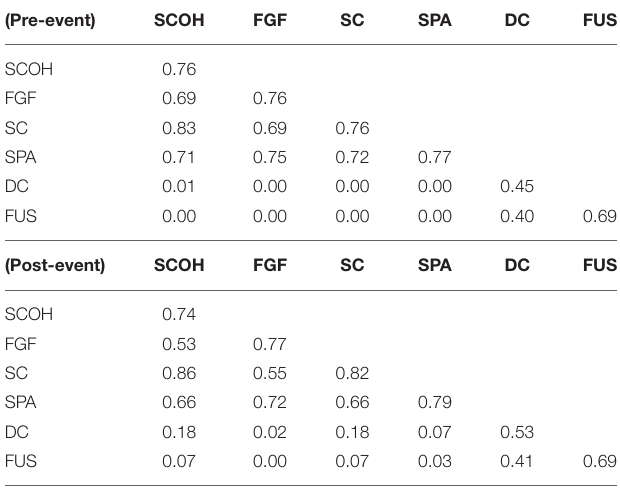
TABLE 3 | Discriminant validity (average variance extracted value for each construct with the squared correlations between the respective constructs).